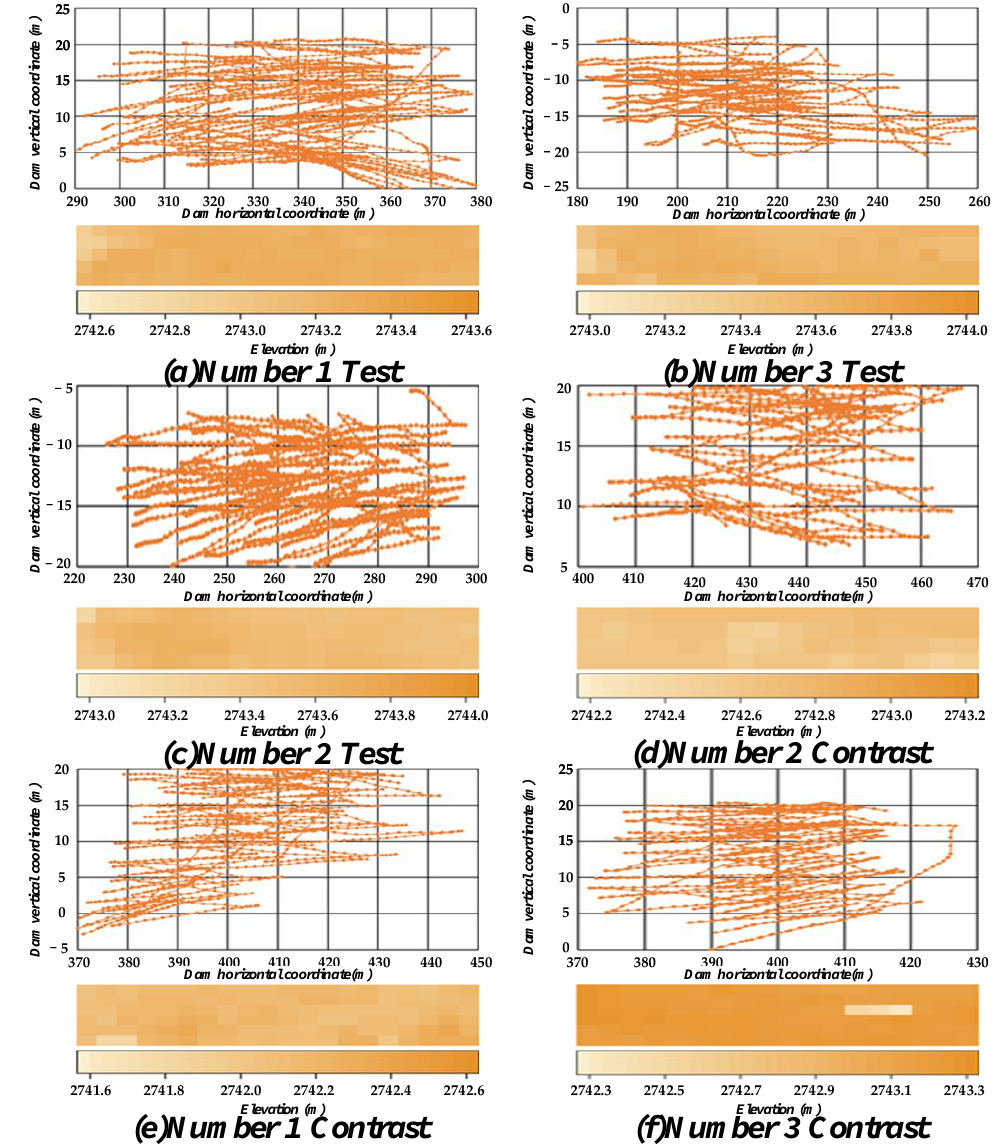
Figure 14. Trajectory of bulldozers and corresponding graphic reports for each test and contrast